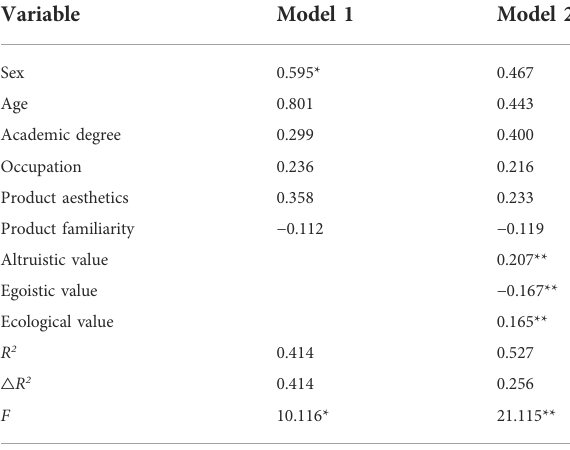
TABLE 4 Results of multivariate regression analysis.